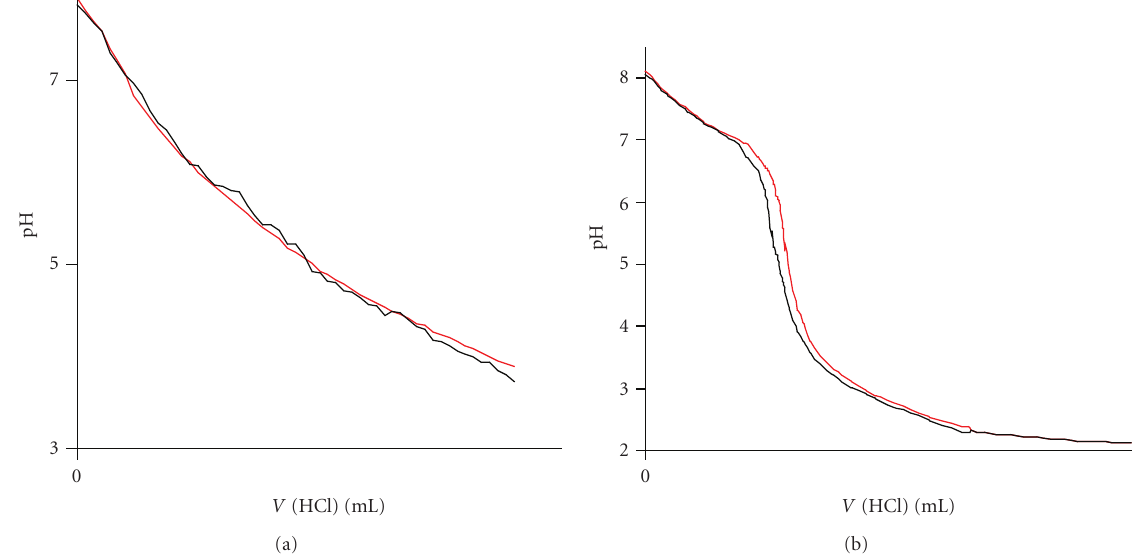
Figure 2: Potentiometric titrations for the Cu(II)-H 4 cacp (1:1) and Cu(II)-H 6 bicah (2:1) systems (a) and (b), respectively) as a function of pH over the range 2.00–10.0 at molar concentration 2.50mmoldm − 3 based on ligand (25 ◦ C, I = 0 . 10 moldm − 3 KCl, pK w = 13 . 78, γ = 0 . 78, and HCl = 0 . 111 mmoldm − 3 ). The line denoted with black colour refers to the experimental titration curve while the red refers to the computational fitting of the obtained experimental data.